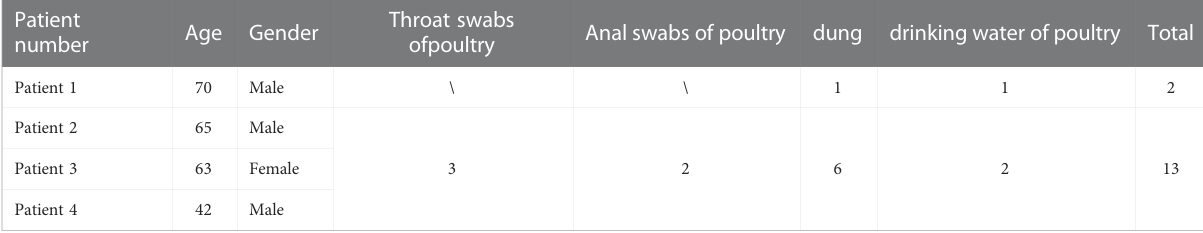
TABLE 2 C . psittaci positive numbers of environmental samples from four patients. Patient Throat swabs Age Gender Anal swabs of poultry dung drinking water of poultry number ofpoultry